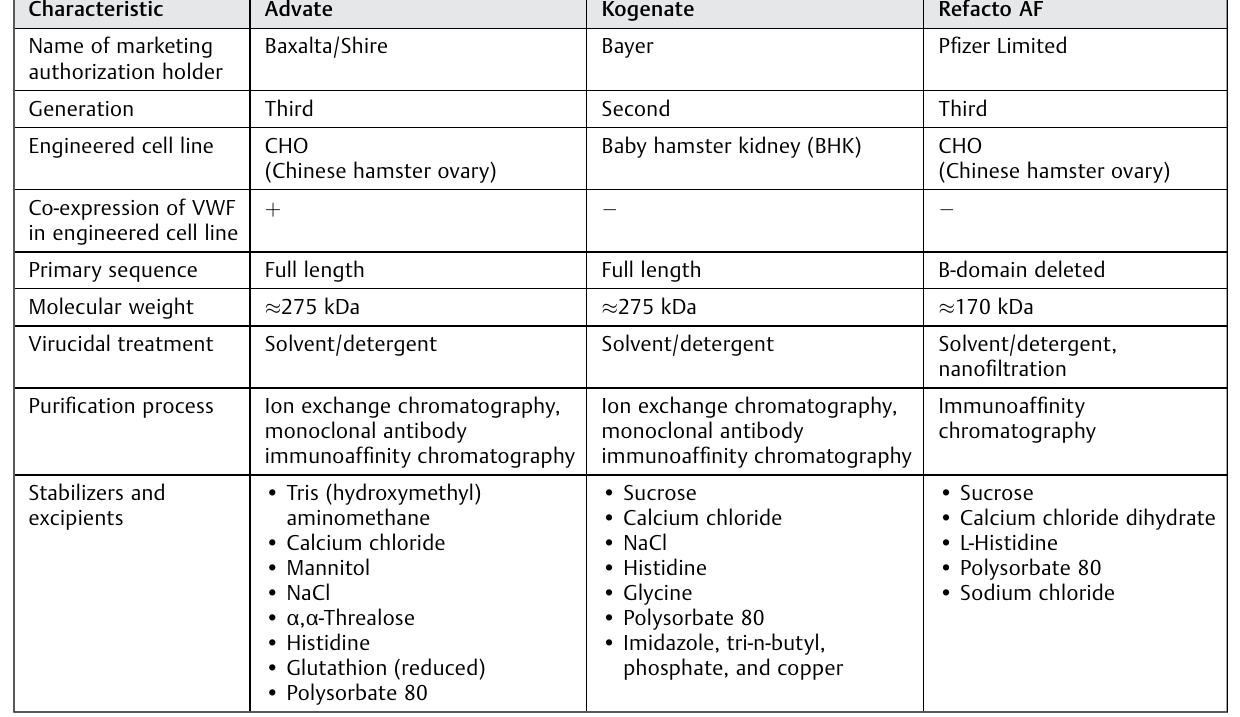
Table 1 Main characteristics of the three recombinant Factor VIII products used in the study Characteristic